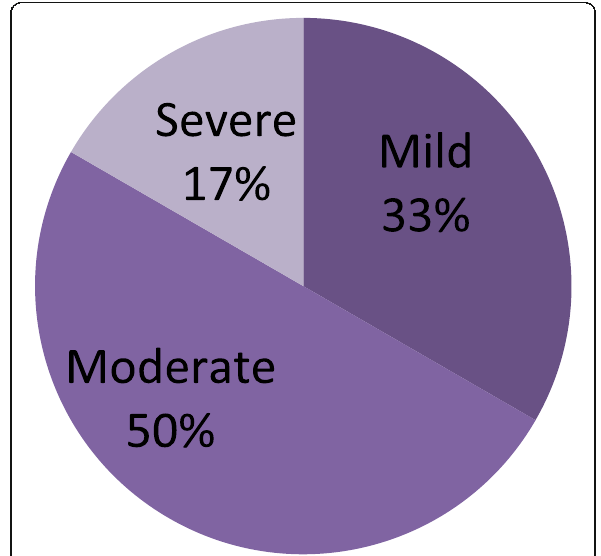
Fig. 6 Percentage of patients according to the degree of PR in post- TOF repair by MRI. *PR: pulmonary regurge, TOF: tetralogy of